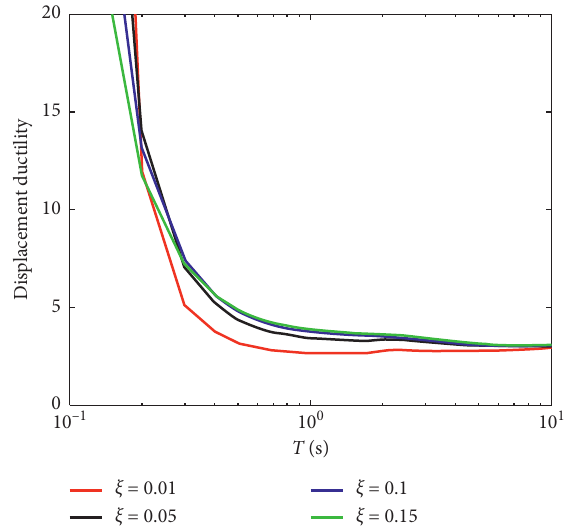
Figure 6: Effect of ζ ( ζ � 0.01, 0.05, 0.1, and 0.15) on the variation of the mean constant-strength ductility